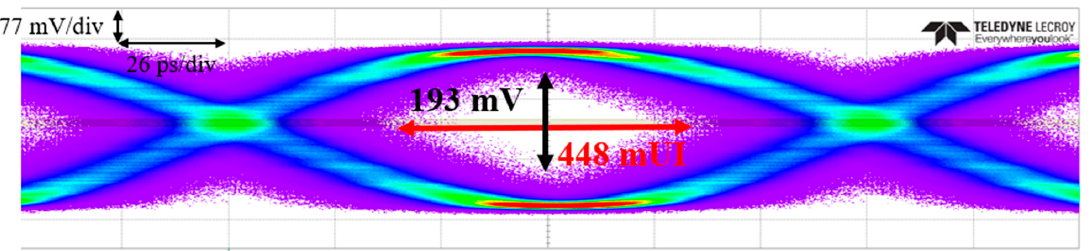
Figure 12. Eye diagram of the PLL without synchronization by injection. The recovered eye gives an opening of 193 mV by 448 mUI. The measured jitter rms indicates 29.7 mUI.